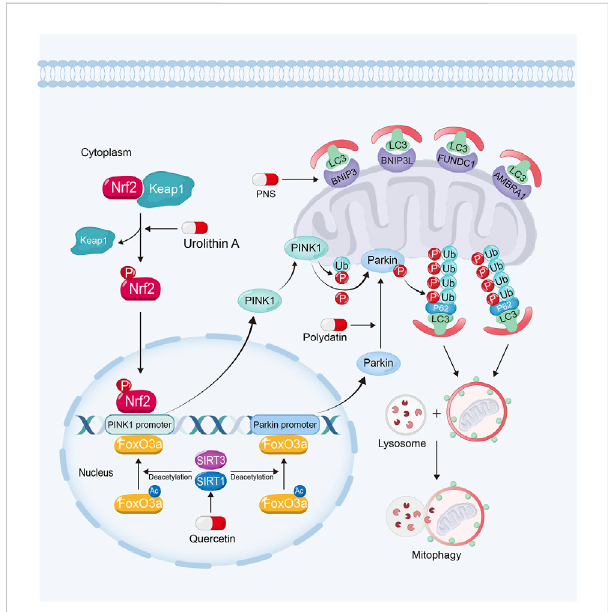
FIGURE 4 Polydatin promotes mitophagy by driving Parkin translocation from cytosol into OMM in kidney diseases. Quercetin can upregulate PINK1 and Parkin expression via sirtuin-1-FoxO3a-PINK1/Parkin signaling pathway. Urolithin A enhances mitophagy in kidney diseases byNrf2-PINK1pathway and PNS enhances mitophagy via the upregulation of